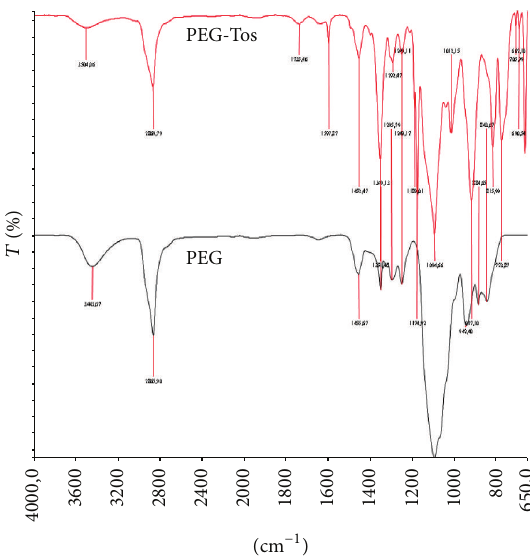
Figure 1: FTIR-ATR spectrum of PEG-Tos and PEG.